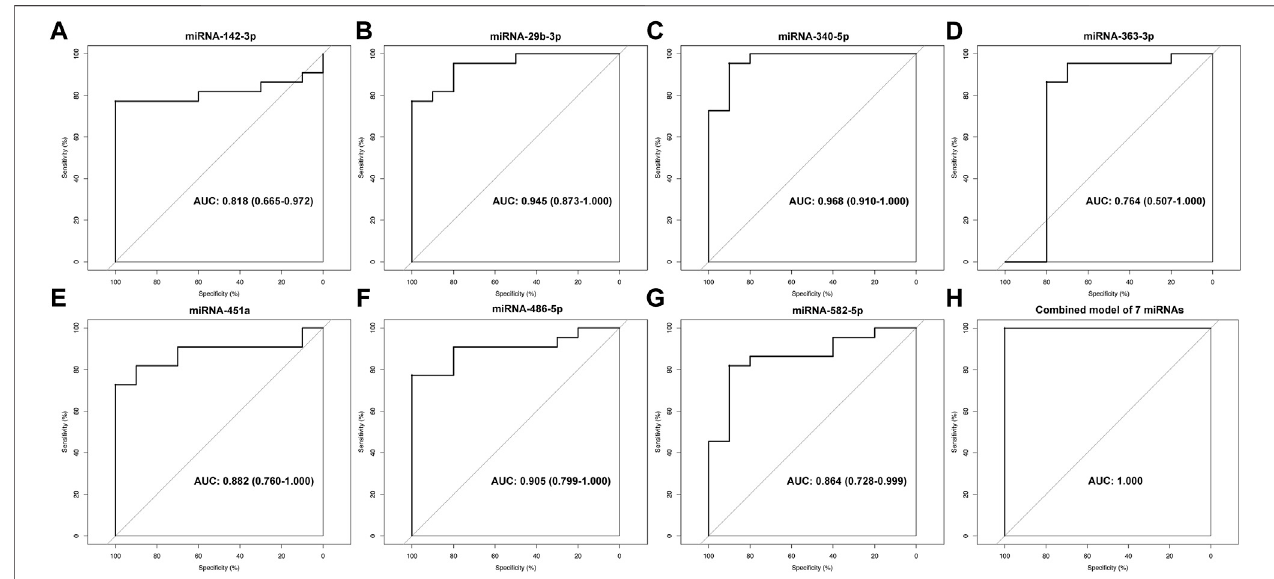
FIGURE 5 | ROC analysis of miRNA-142-3p (A) , miRNA-29b-3p (B) , miRNA-340-5p (C) , miRNA-363-3p (D) , miRNA-451a (E) , miRNA-486-5p (F) , miRNA-582- 5p (G) and combined model of 7 miRNAs (H) for diagnosis of MMD.